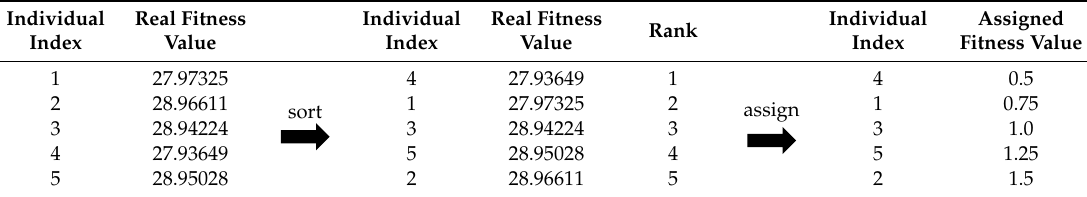
Table 1. A simple example of rank-based fitness assignment method.